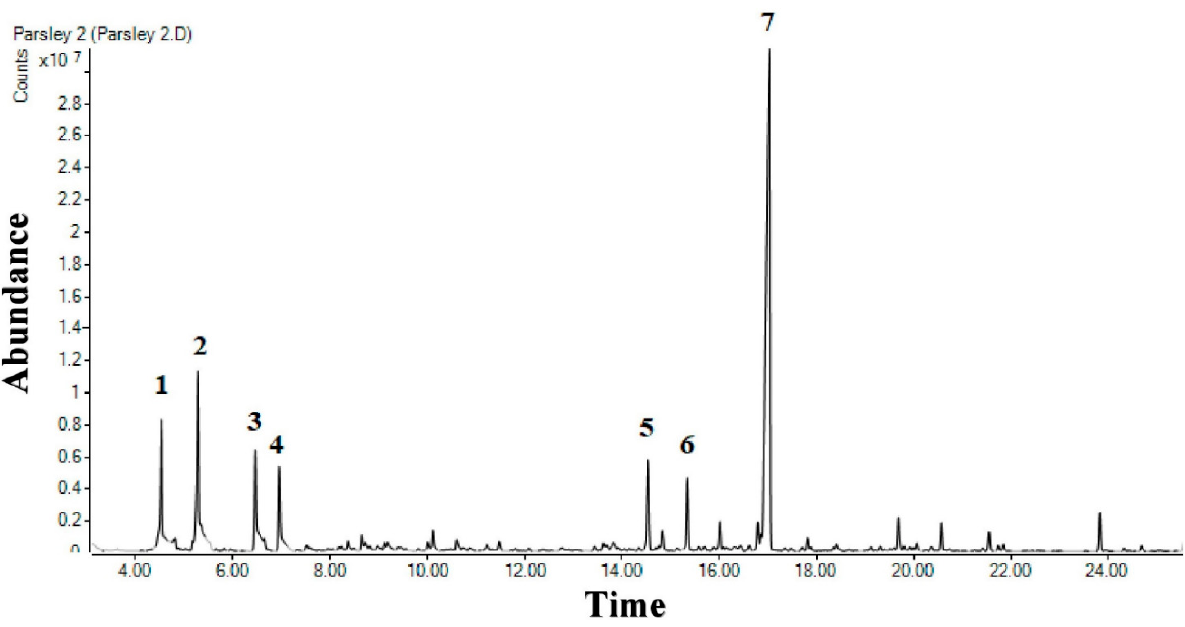
Figure 1. Total ion chromatograms of GC/MS of PCEO using HP-5MS. Table 1. Chemical composition of PCEO analysed using GC-MS .